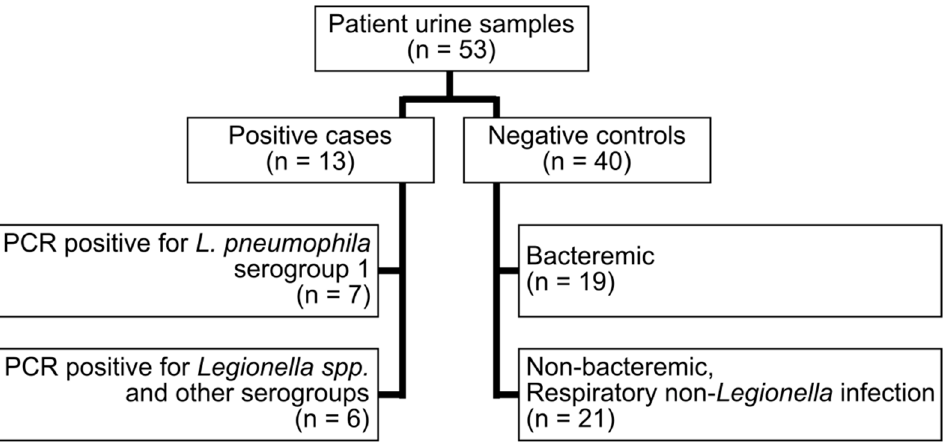
Figure 1. Patient urine samples included in the study.